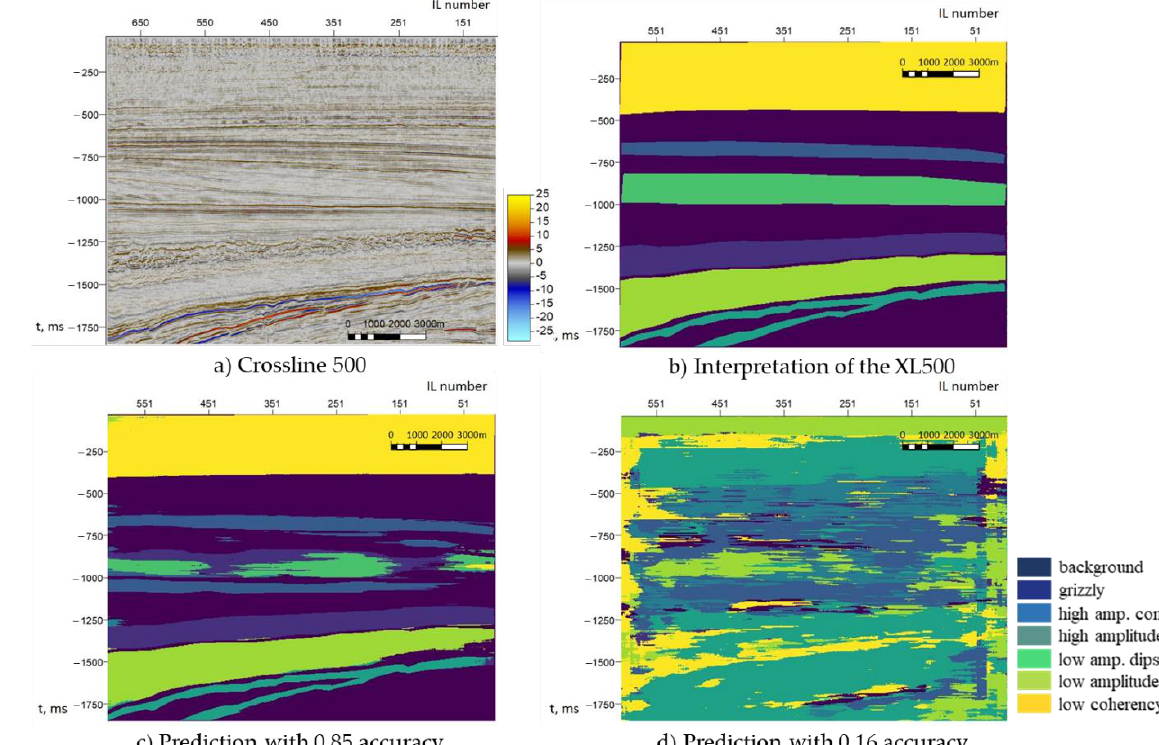
Figure 11. XL500 ( a ) along with its interpretation ( b ), prediction with 0.85 accuracy ( c ), prediction with 0.16 accuracy ( d ). Prediction performance of the fully convolutional 2D network varies significantly with slight changes in parameter.